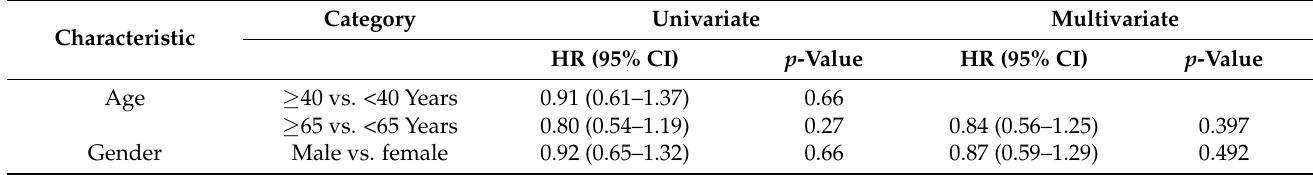
Table 4. Univariate and multivariate analyses of factors associated with overall